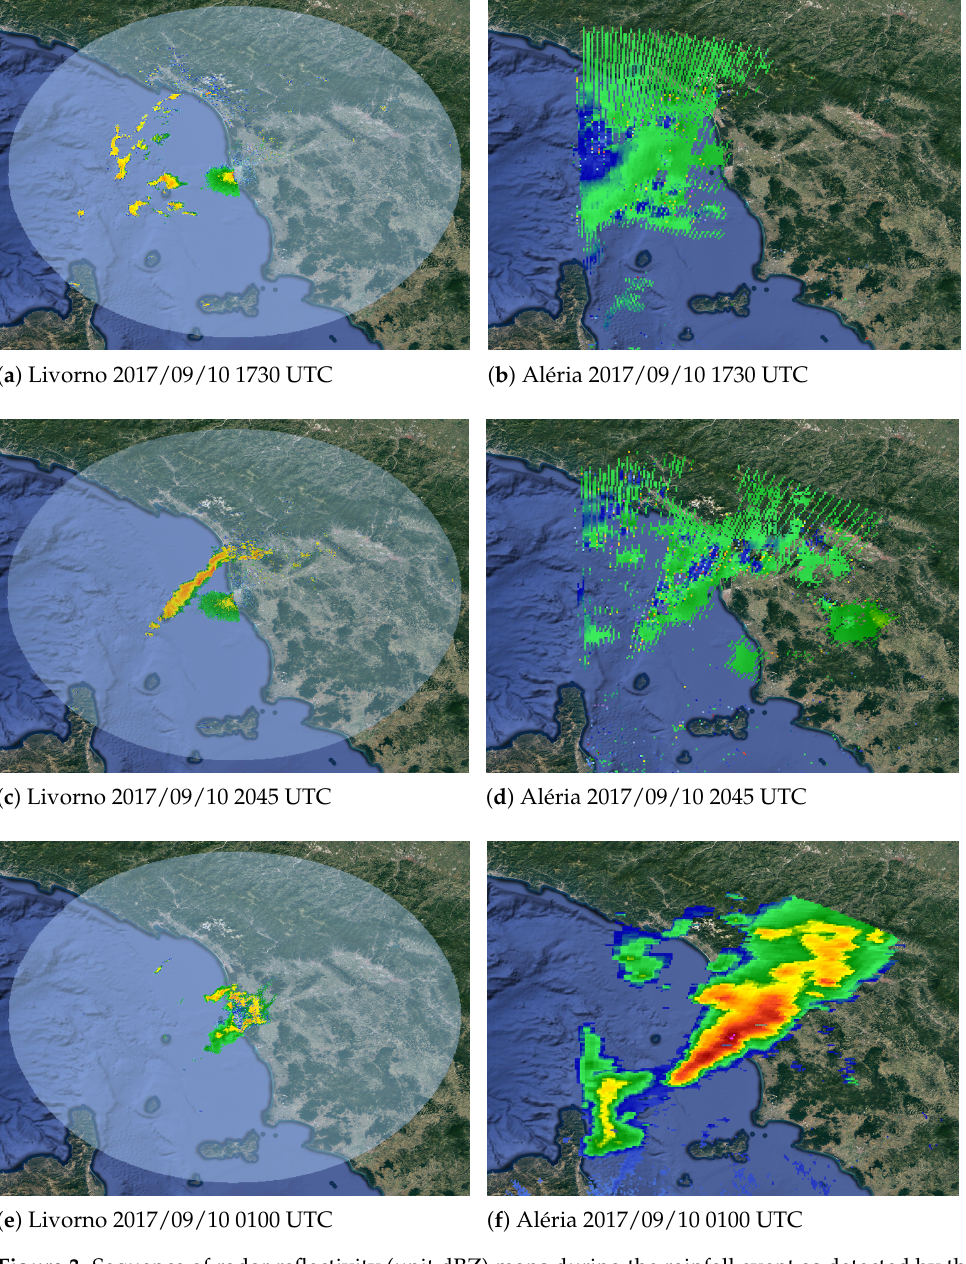
Figure 3. Sequence of radar reflectivity (unit dBZ) maps during the rainfall event as detected by the Livorno ( left ) and Aléria ( right ) radar systems. ( a , b ) At 1730 UTC on 9 September. ( c , d ) At 2045 UTC on 9 September. ( e , f ) At 0100 UTC on 10